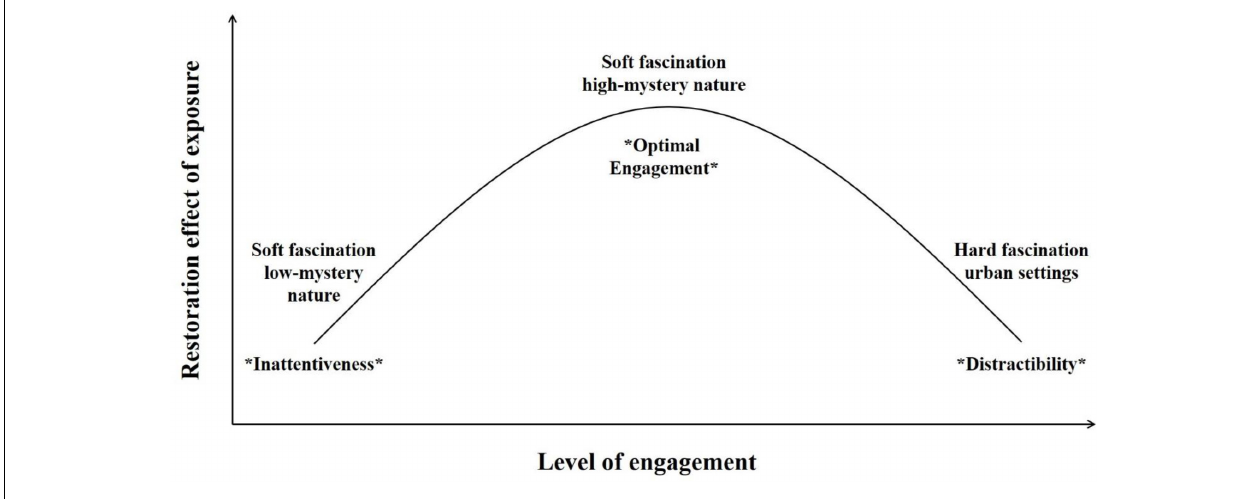
FIGURE 4 | Hypothesized relationship between engagement and attention